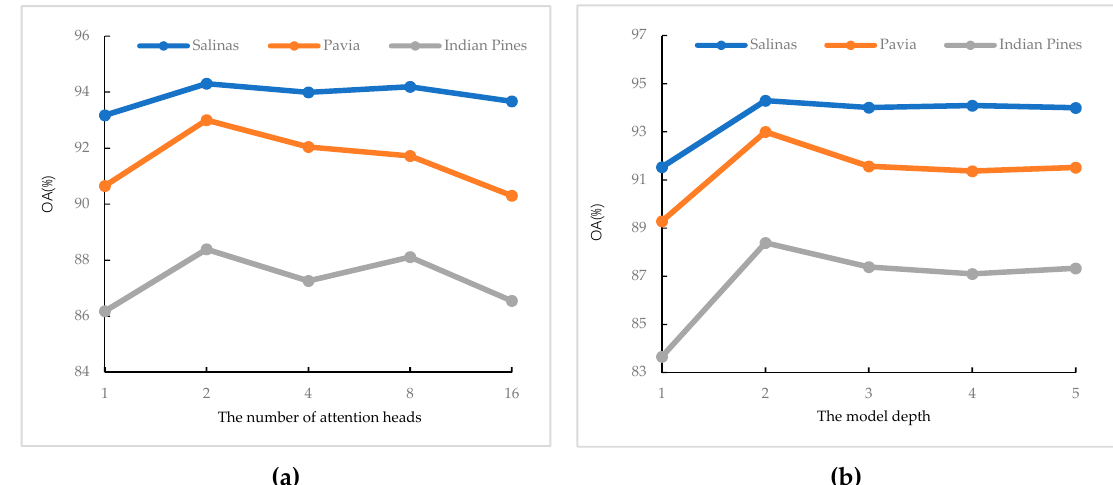
Figure 7. Results of SST varying ( a ) the number of attention heads and ( b ) the model depth. 𝜺 is the smoothing factor of T-SST-L; to validate the influences of T-SST-L with dif- ferent values of 𝜺 , the grid search method is utilized to search the optimal value of 𝜀 var- ying from 0.2 to 0.9. The OA of different values of 𝜺 is shown in Figure 8. As can be seen, the OAs of different values of 𝜀 are fluctuant, but the proposed T-SST-L obtains the best result when the value of 𝜀 is set to 0.9 on the three datasets. Therefore, in all experiments, the value of 𝜀 is set to 0.9 for all datasets to obtain the best performance for HSI classifica- tion.